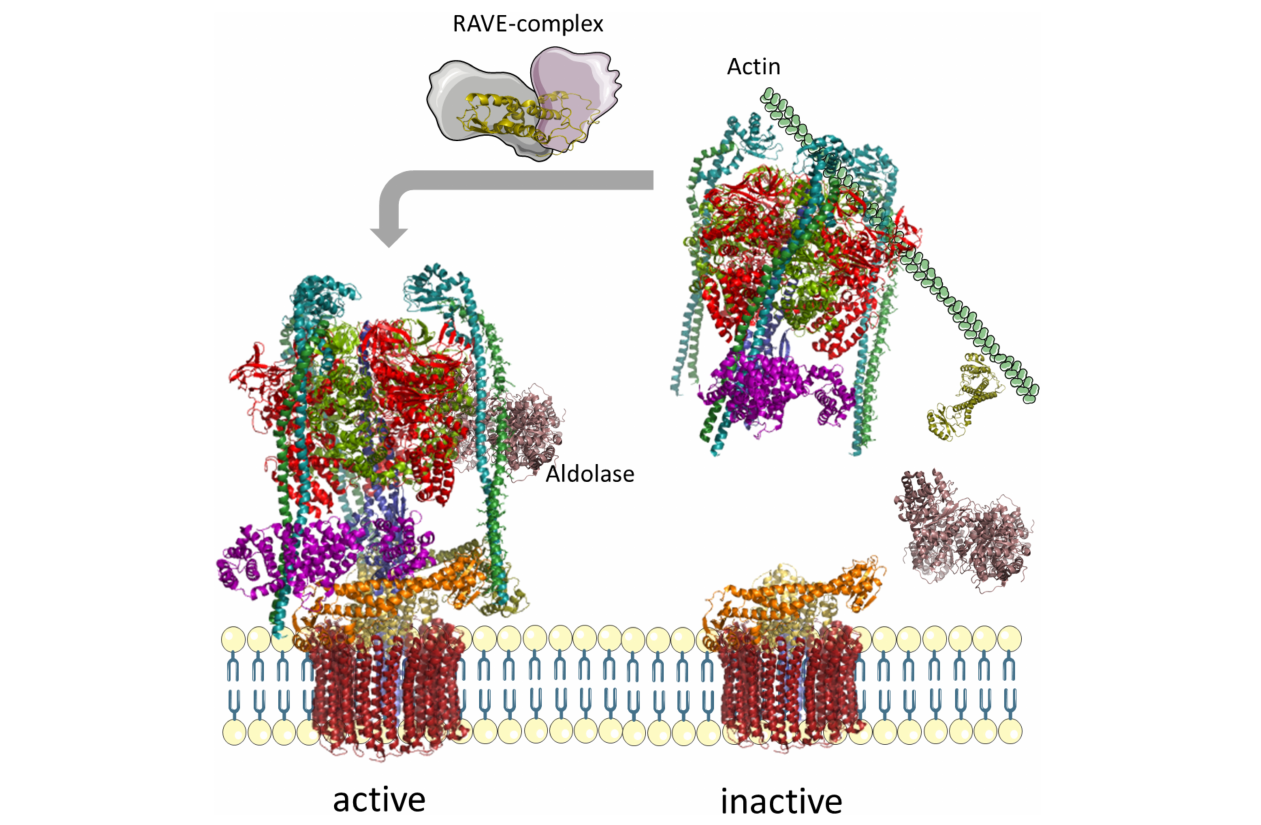
FIGURE 6 | Reversible assembly of yeast V-ATPases. In the absence of glucose, the glycolytic aldolase dissociates from the complex, followed by VHA-C and the entire V 1 -sector; VHA-C and the residual V 1 sector bind to actin to prevent free diffusion. Supply with glucose results in re-assembly of V-ATPase, mediated by the RAVE complex. The structure of V-ATPase relies on pdb-file 3j9t, the aldolase on 7ka2, and Skp1 on 5xyl (Zhao et al., 2015; Shukla et al., 2018; Cash et al., 2020).